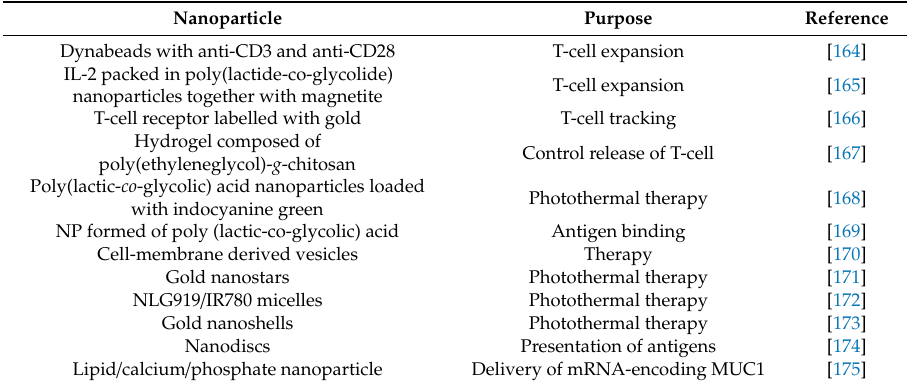
Table 5. Potential use of nanoparticles in